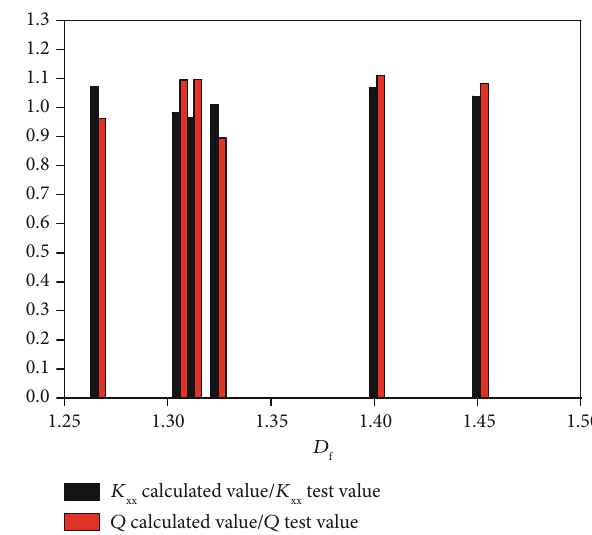
Figure 20: Comparison of theoretical model and water injection test K . xx